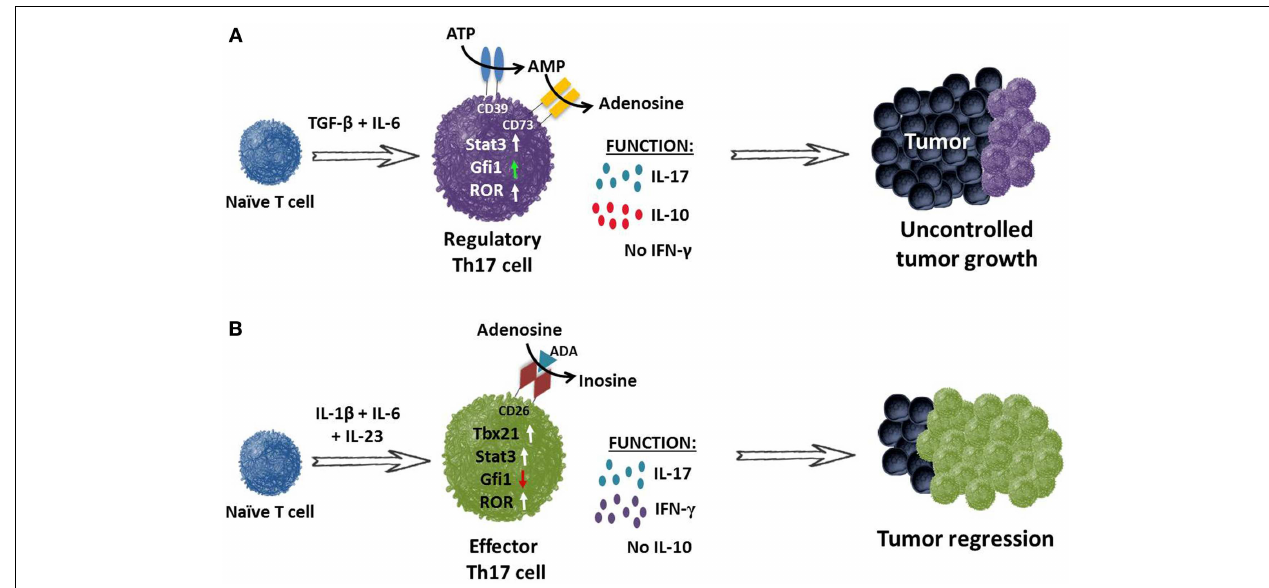
IL-6 and IL-23 supports the generation ofTh17 cells that secrete IL-17A and express ROR γ t and STAT3. Moreover, these cells also express transcription factorTbx21 and co-secrete IL-17 and IFN- γ but not the immunosuppressive cytokine IL-10.These inflammatoryTh17 cells also express increased Gfi1. It is also possible that they express CD26, which facilitates the conversion of adenosine to inosine upon binding of adenosine deaminase (ADA).These infused cells promote the activation of CD8 + effectorT cells and cooperate to mediate tumor regression in an IFN- γ and IL-17A-dependent